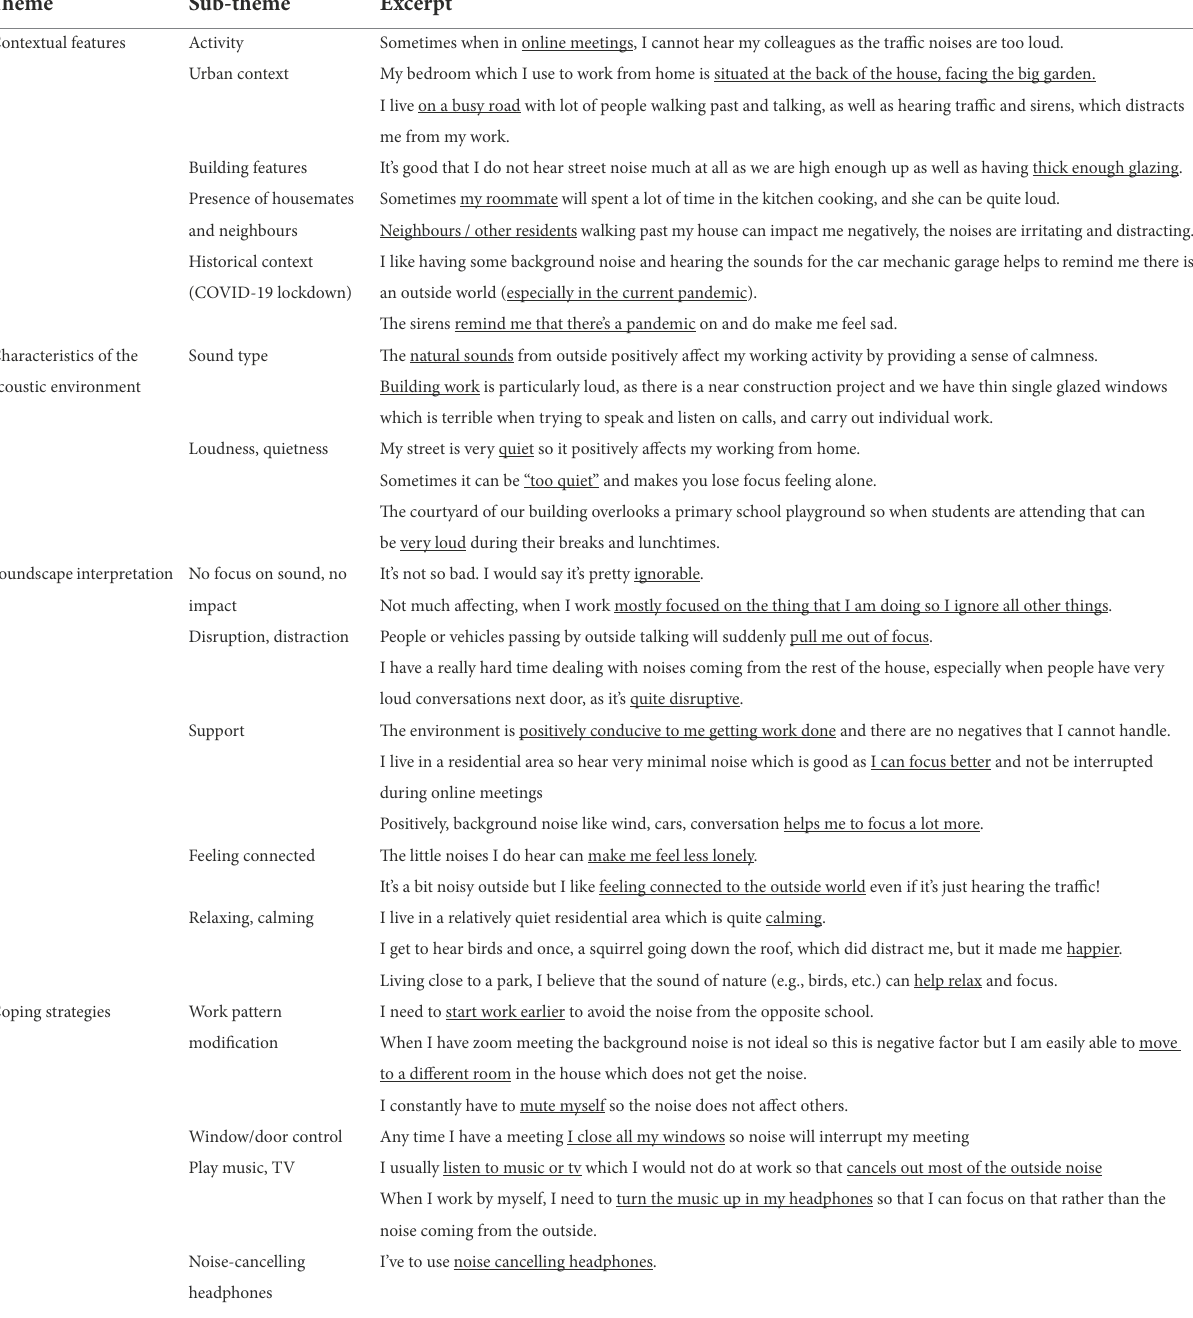
TABLE 2 Example of excerpts and coded fragments (underlined) related to themes and sub-themes defined from the thematic analysis for soundscape impacts on WFH. Theme Sub-theme Contextual